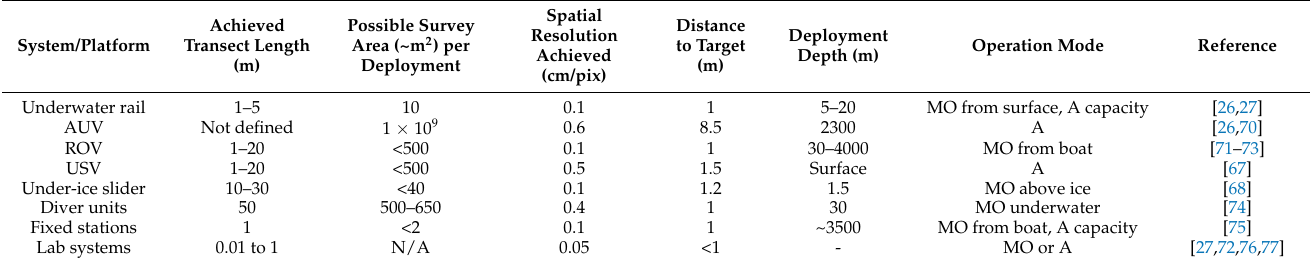
Table 1. Overview of current UHI systems for data acquisition along with their seafloor mapping capabilities and tradeoffs.